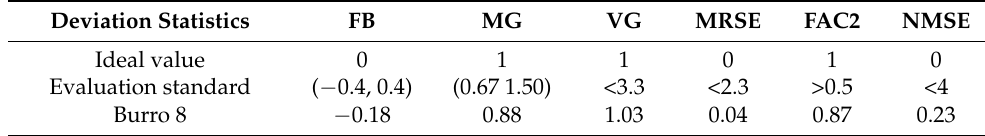
Table 2. The error comparison of simulation results.